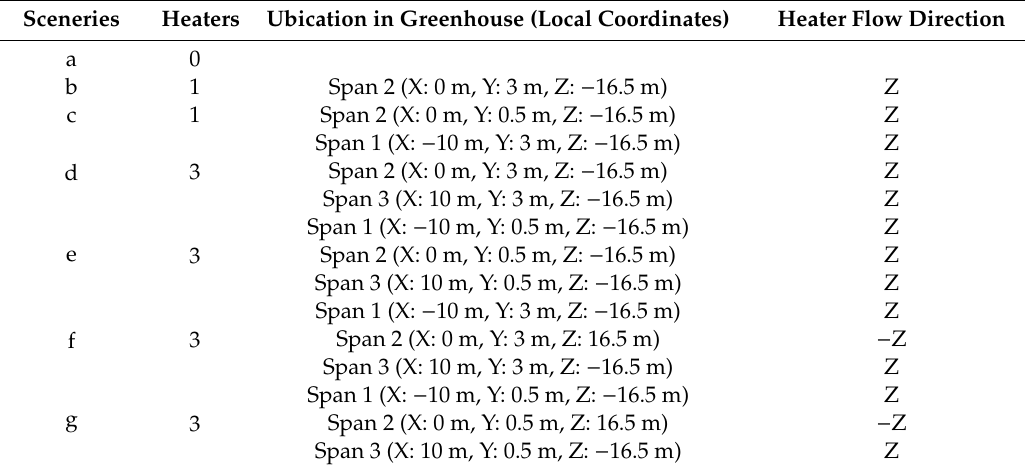
Table 4. Simulation scenarios (X transversal, Z longitudinal, Y